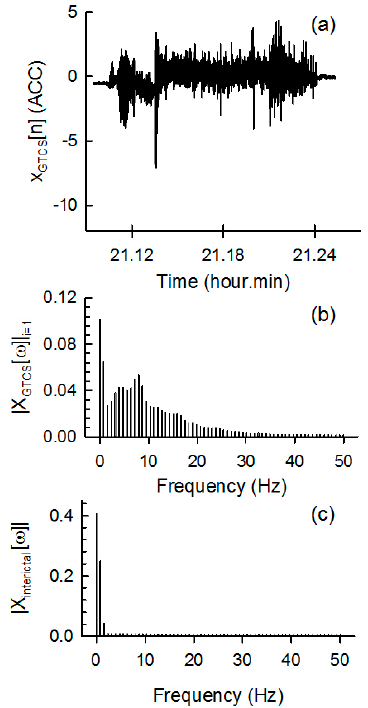
Figure 3. Example of ( a ) the GTCS ACM data as a function of recording time; ( b ) the spectral information of ( a ); and ( c ) the spectral information of the non-GTCS ACM data (interictal).